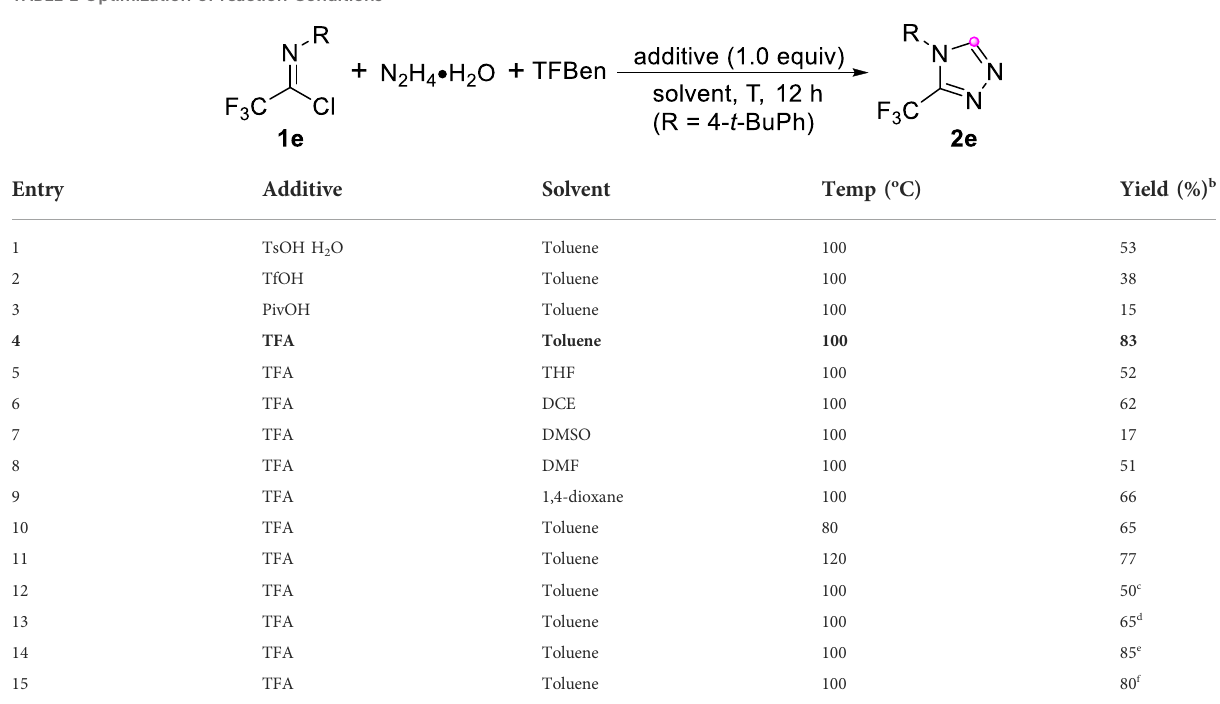
TABLE 1 Optimization of reaction Conditions a